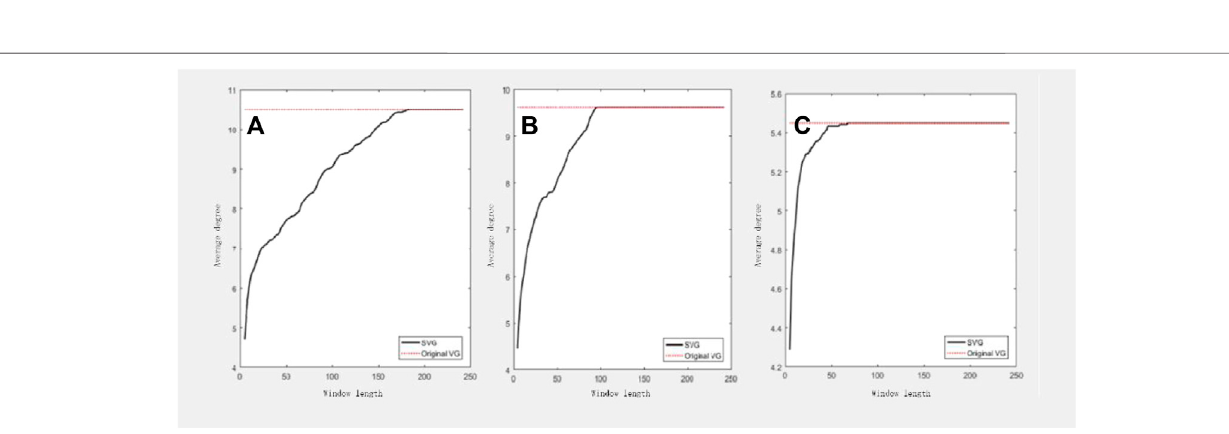
TABLE 1 | Comparison of network construction through SVG for different types of time series data. Data description